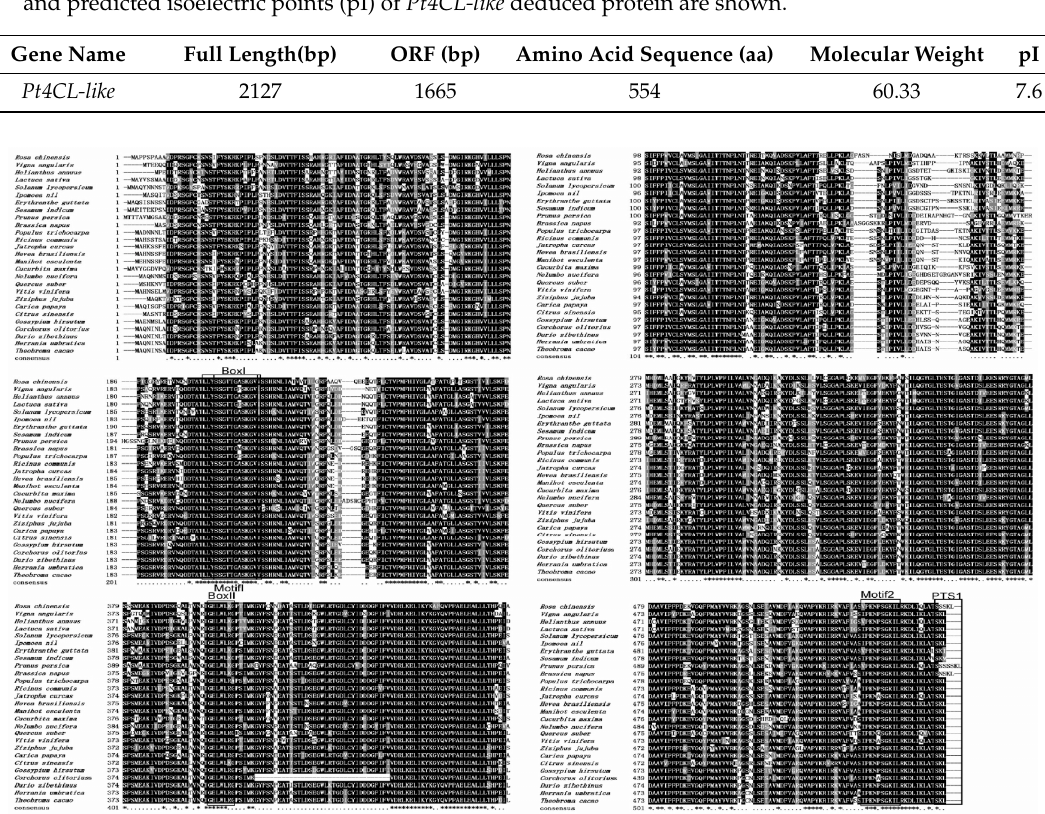
Figure 1. Comparison of the deduced amino acid sequences of conserved regions of Populus trichocarpa . Pt4CL-like and the corresponding sequences of other known AMP-forming acetyl-CoA synthetase (ACS) proteins, including Gossypium arboreum (XP 017613221.1), Corchorus olitorius (OMO85482.1), Durio zibethinus (XP 022772588.1), and Ricinus communis (XP 002510640.1) are shown. Two domains, box I and box II, are numbered and indicated by a box. A putative peroxisome targeting sequence (PTS0) is also numbered and indicated by a